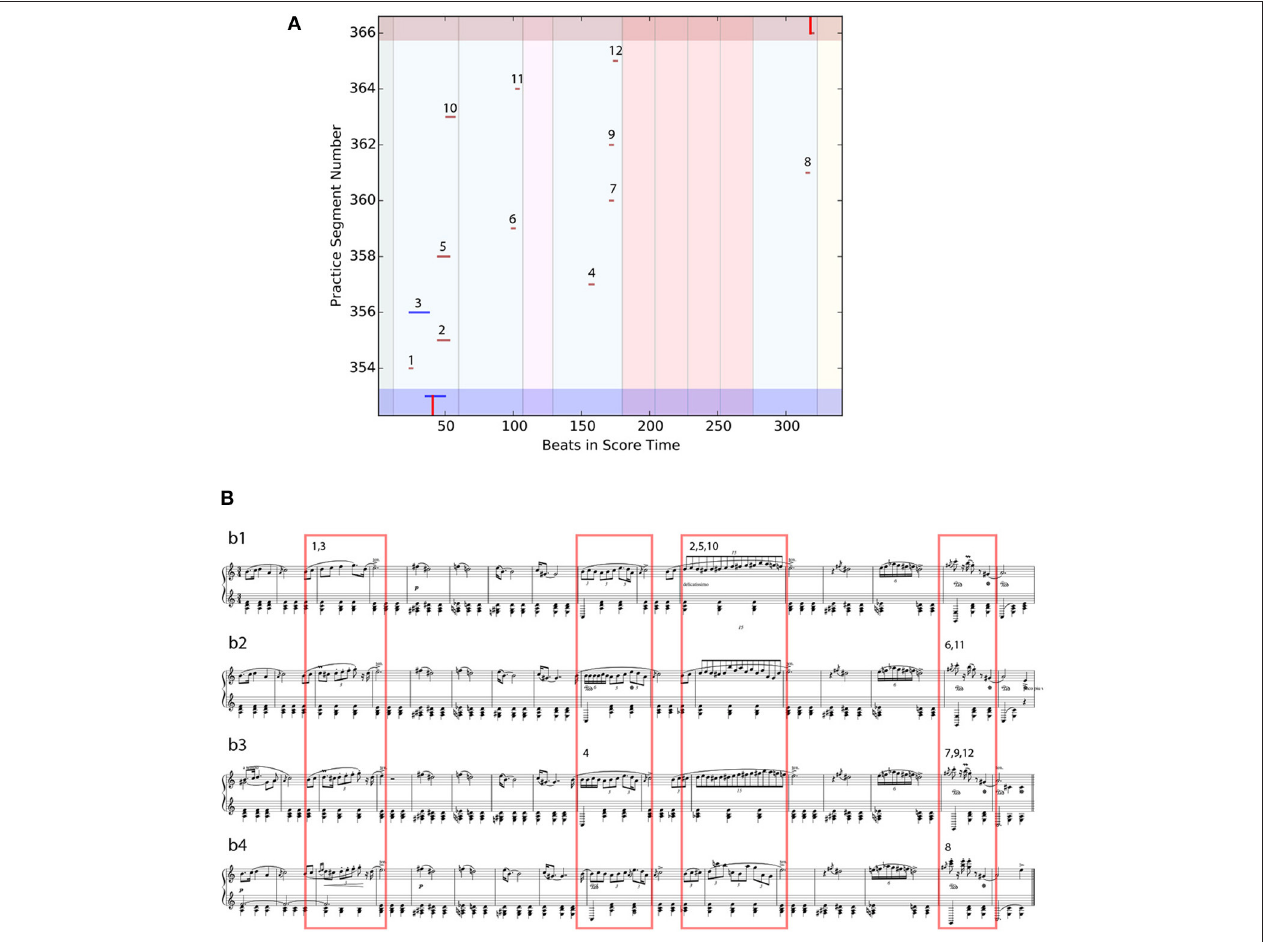
FIGURE 16 | Representation of the Memorization practice pattern. Each number above a practice segment in the PSWM (Top) corresponds to the number inside of the rectangle in the score (Bottom). PSWM excerpt illustrating E-2’s memorization strategy. (A) PSWM excerpt illustrating E-2’s memorization strategy. (B) Corresponding score, showing the four similar subsections, b1, b2, b3, b4 (see Figure 6 ). Red boxes show parts repeated with variations. Numbers link score fragments to practice segments.